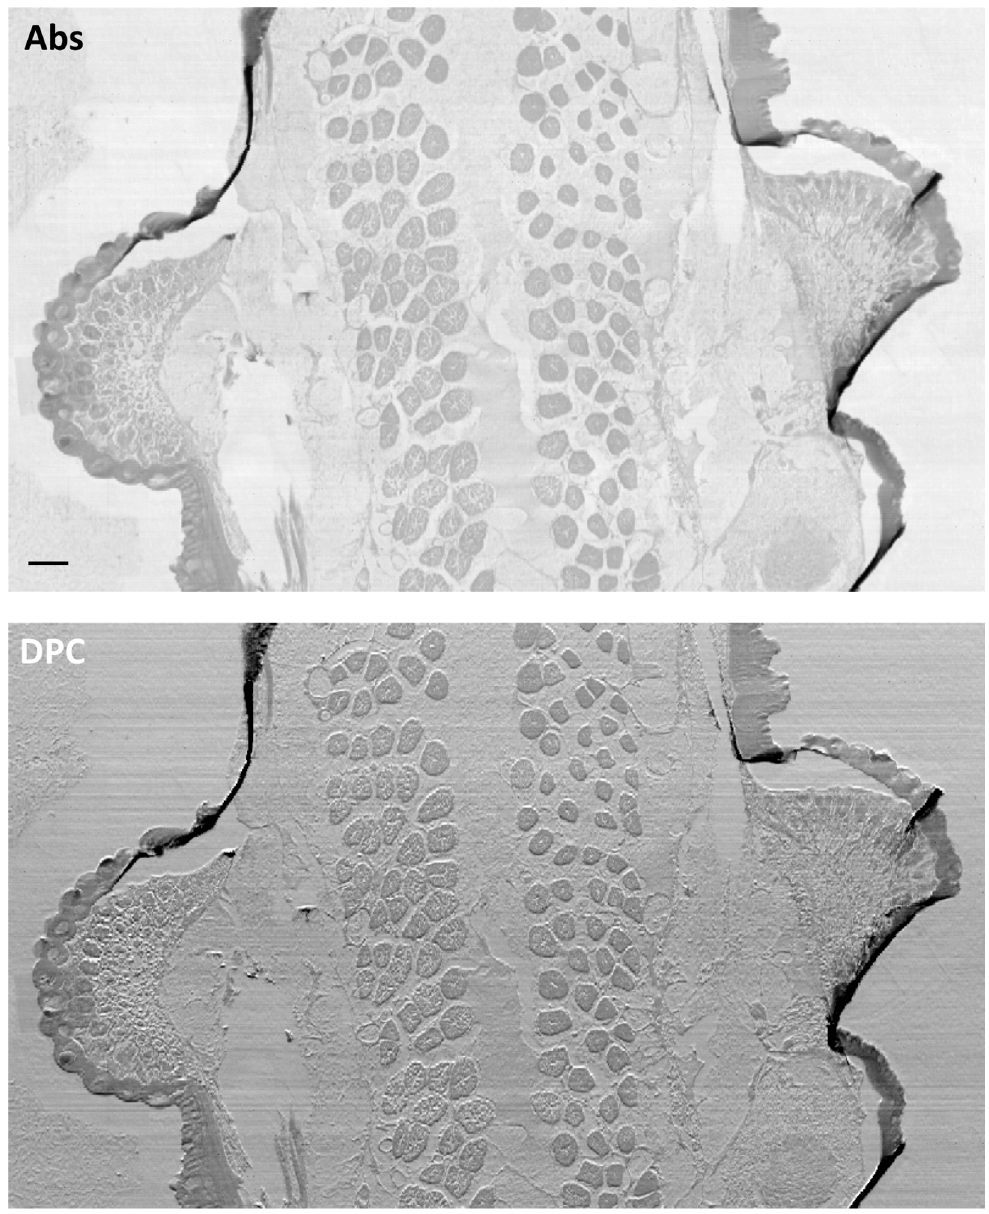
Figure 9. Absorption (Abs) and differential phase contrast (DPC) images of a section of a Rhodnius prolixus head [80] acquired at a 1.7 keV excitation energy over an area of 1200 µm × 720 µm with a 1.5 µm step size and probe size, and 50 ms acquisition time. Scale bar is 50 µm.